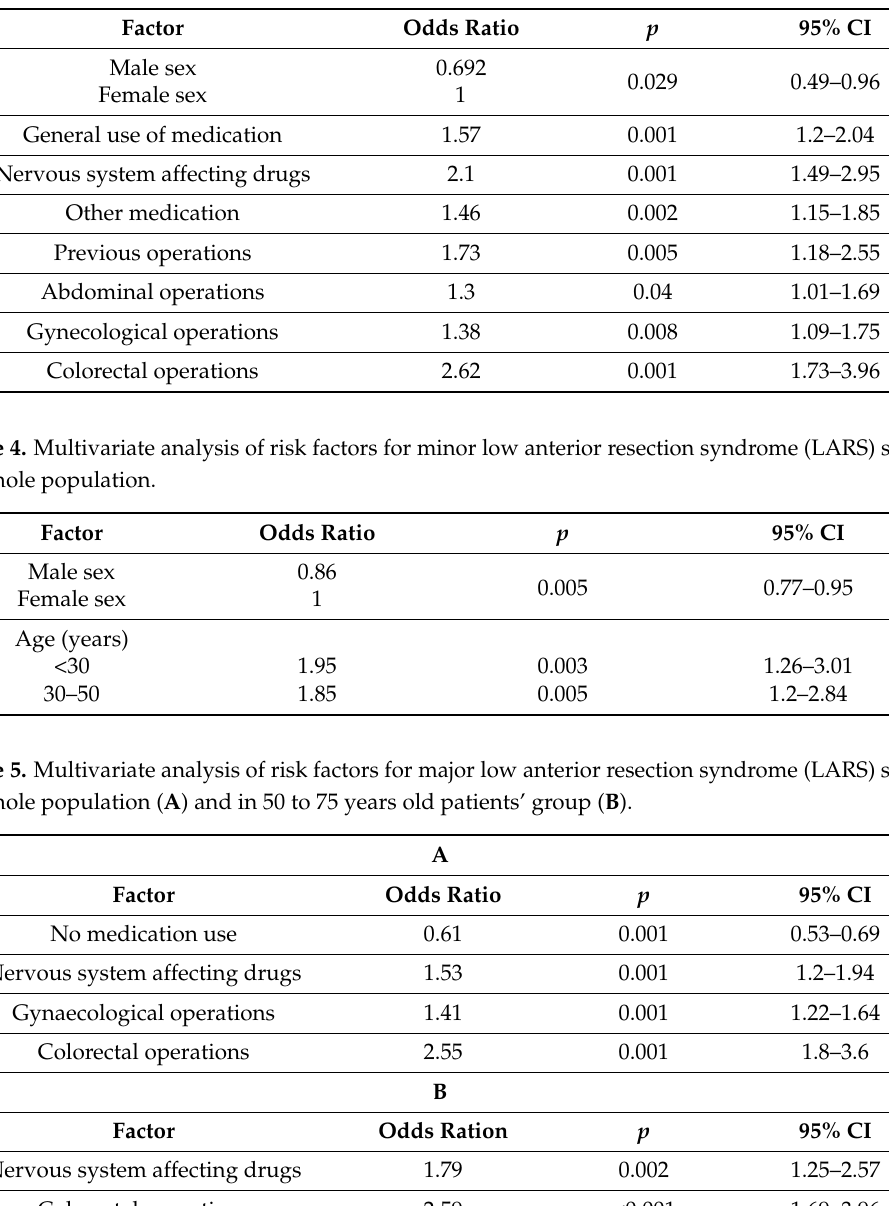
Table 3. Univariate analysis for risk factors for minor low anterior resection syndrome (LARS) score of whole population.